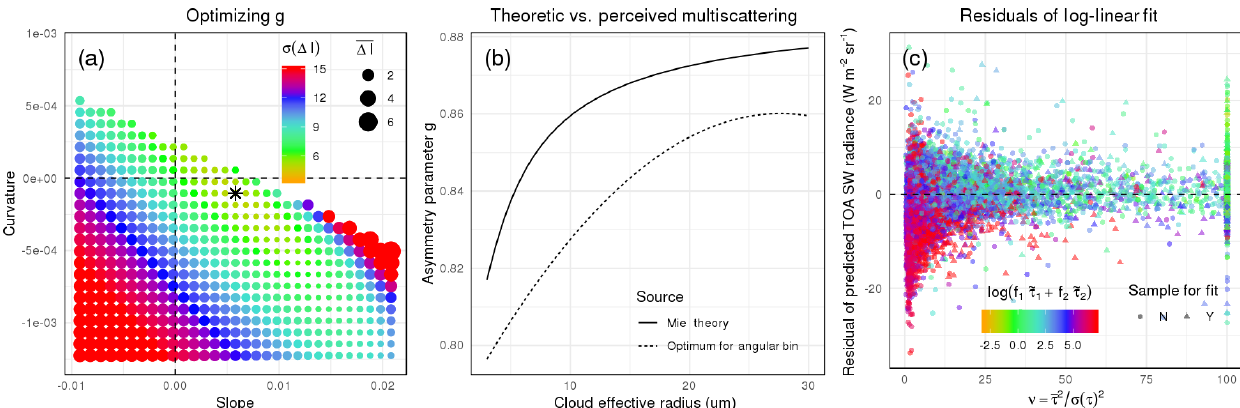
Figure 2. For the same angular bin as in Fig. 1, we present details of the proposed model that highlight essential steps aside from log-linear least-square fitting (Eq. 4). Panel (a) shows the search for an optimal g(R e ) (as described in Sect. 3.2): we plotted a two-dimensional slice (showing b and c of Eq. 14) through the three-dimensional space (spanned by a , b , and c ). Colors show the SD of radiance residuals and point size relates to model bias. The star marks the combination of a , b , and c that produced the smallest residual SD and is considered optimal for this bin. Panel (b) compares the g(R e ) of the determined optimal solution against Mie calculations. Panel (c) shows final radiance residuals against cloud homogeneity ( x axis) and cloud optical depth (color). As described in Sect. 3.2.2., only homogeneous ( ν > 10) clouds which were well retrieved (MODIS-reported portion ≥ 80%) – marked as triangles in panel (c) – were conisidered for optimization of g(R e ) and least-square fitting. Statistics and error metrics throughout the paper incorporate all samples.